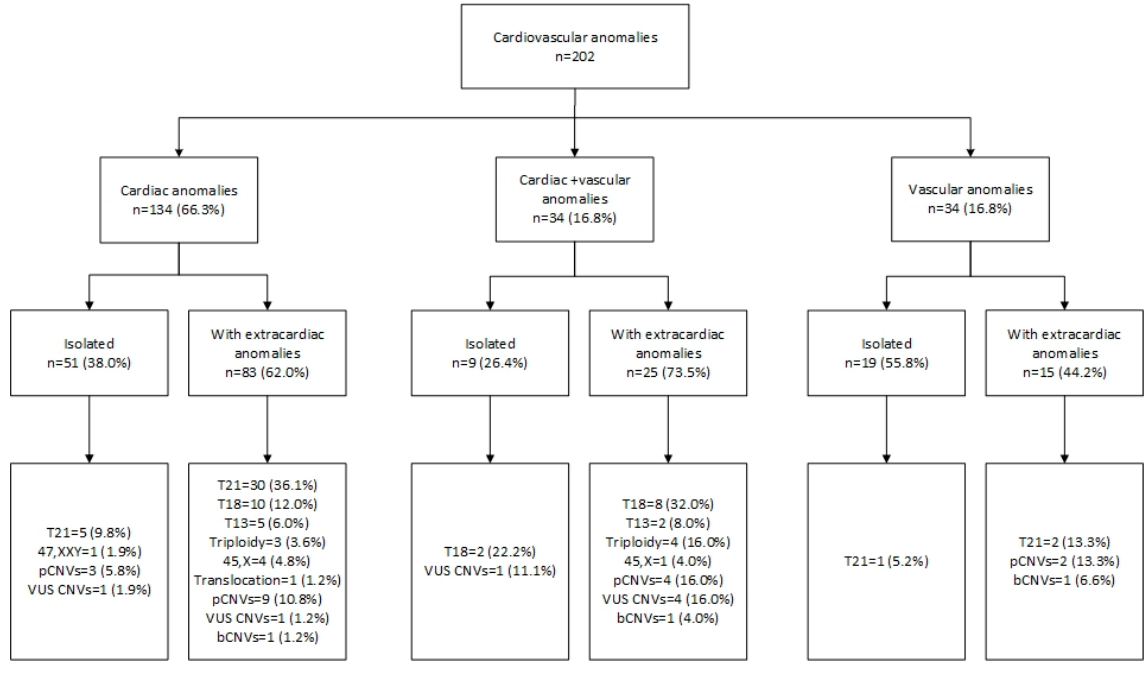
Figure 2. Cardiovascular anomalies and associated genetic findings. bCNVs—benign copy num- ber variants; pCNVs—pathogenic copy number variants; T13—trisomy 13; T18—trisomy 18; T21—trisomy 21; VUS—variants of uncertain clinical significance; 45,X—Turner